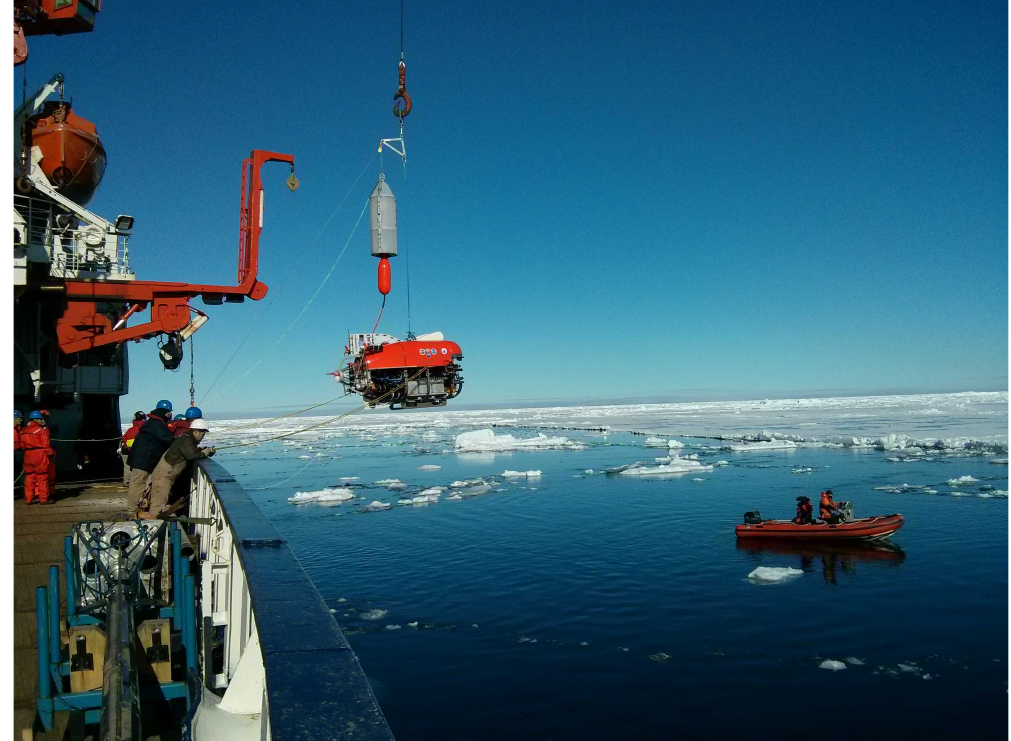
Figure 8. Hybrid ROV/AUV Nereid Under-Ice (NUI) deployment from the F/S Polarstern in July 2014 at 83 ◦ N 6 ◦ W in July 2014. The mated tow-body (orange) and depressor (white) suspended above the vehicle house NUI’s unarmored fiber-optic telemetry system. Actuation of an electromechanical latch separates the tow-body from the depressor at a suitable depth, after which fiber pays out of either body to accommodate the relative motion of the vehicle and ship. Image Credit: L. L.